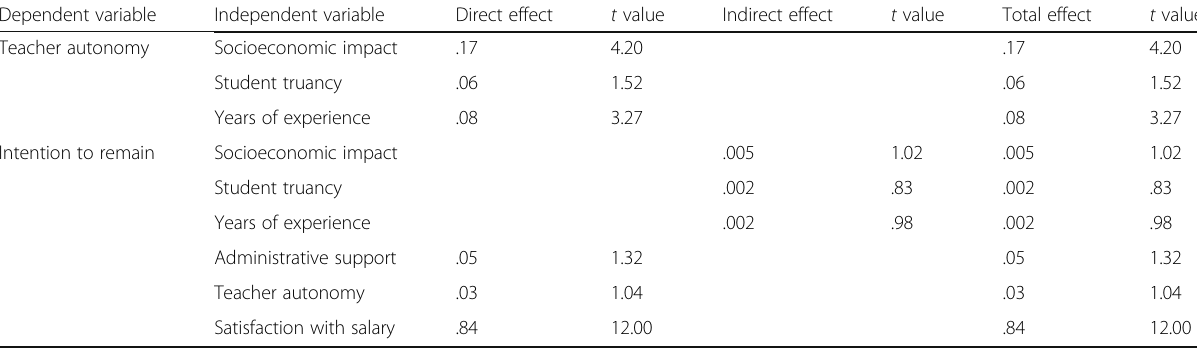
Table 6 Standardized Direct, Indirect, and Total Effects for the Final Structural Model Dependent